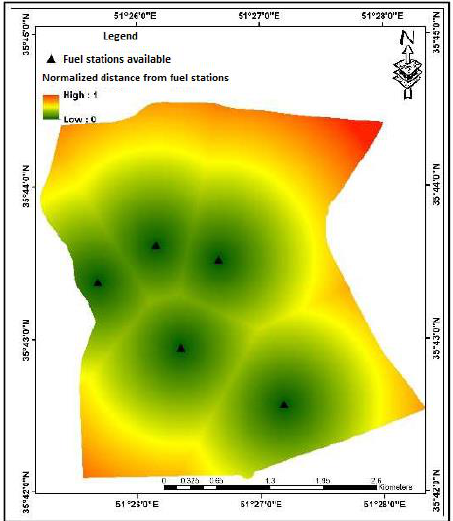
Figure 5. Population density.